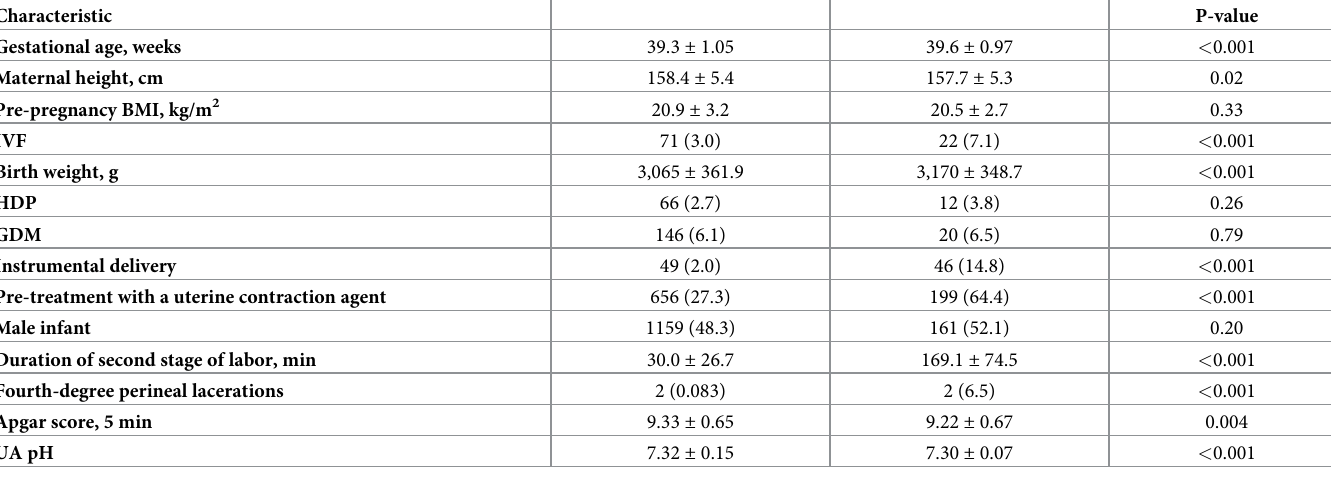
Table 2. Baseline characteristics of the study population.